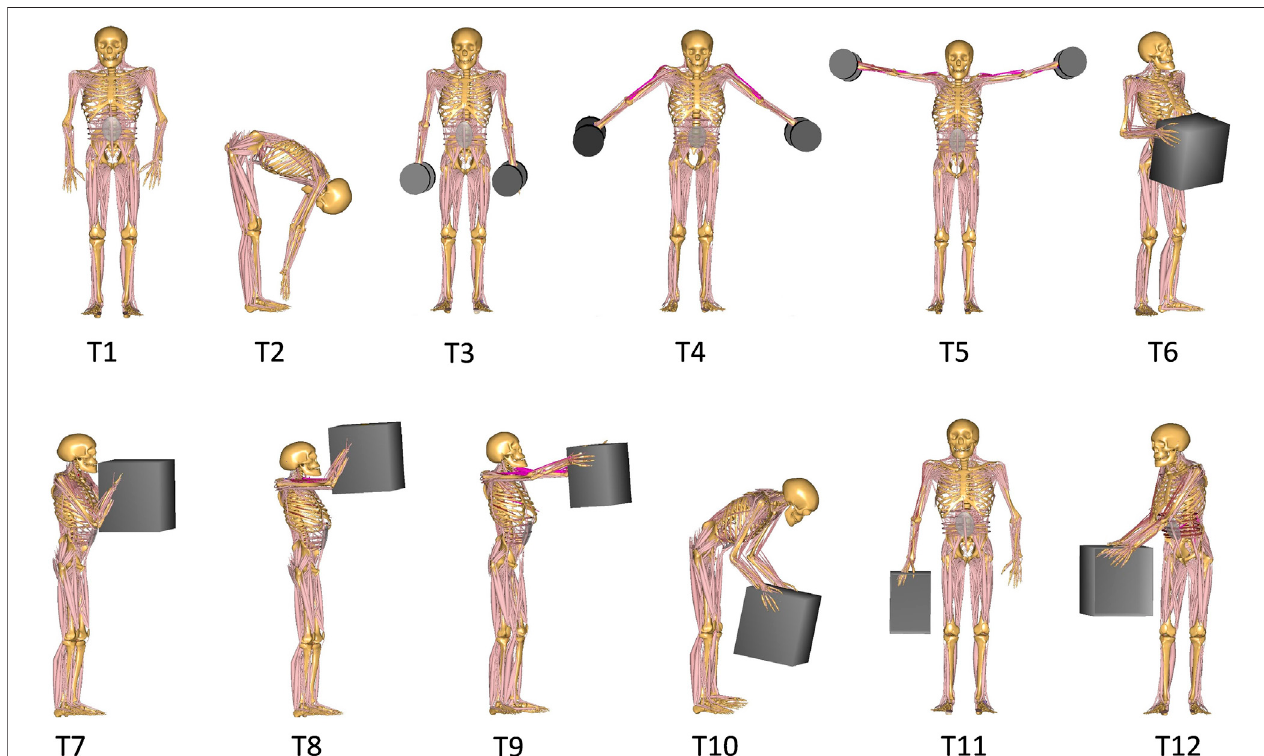
FIGURE 2 | Different lifting tasks performed by participants and simulated by the